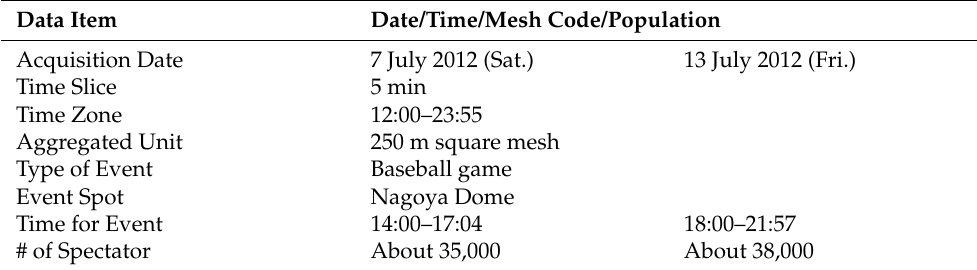
Table 1. Overview of the data